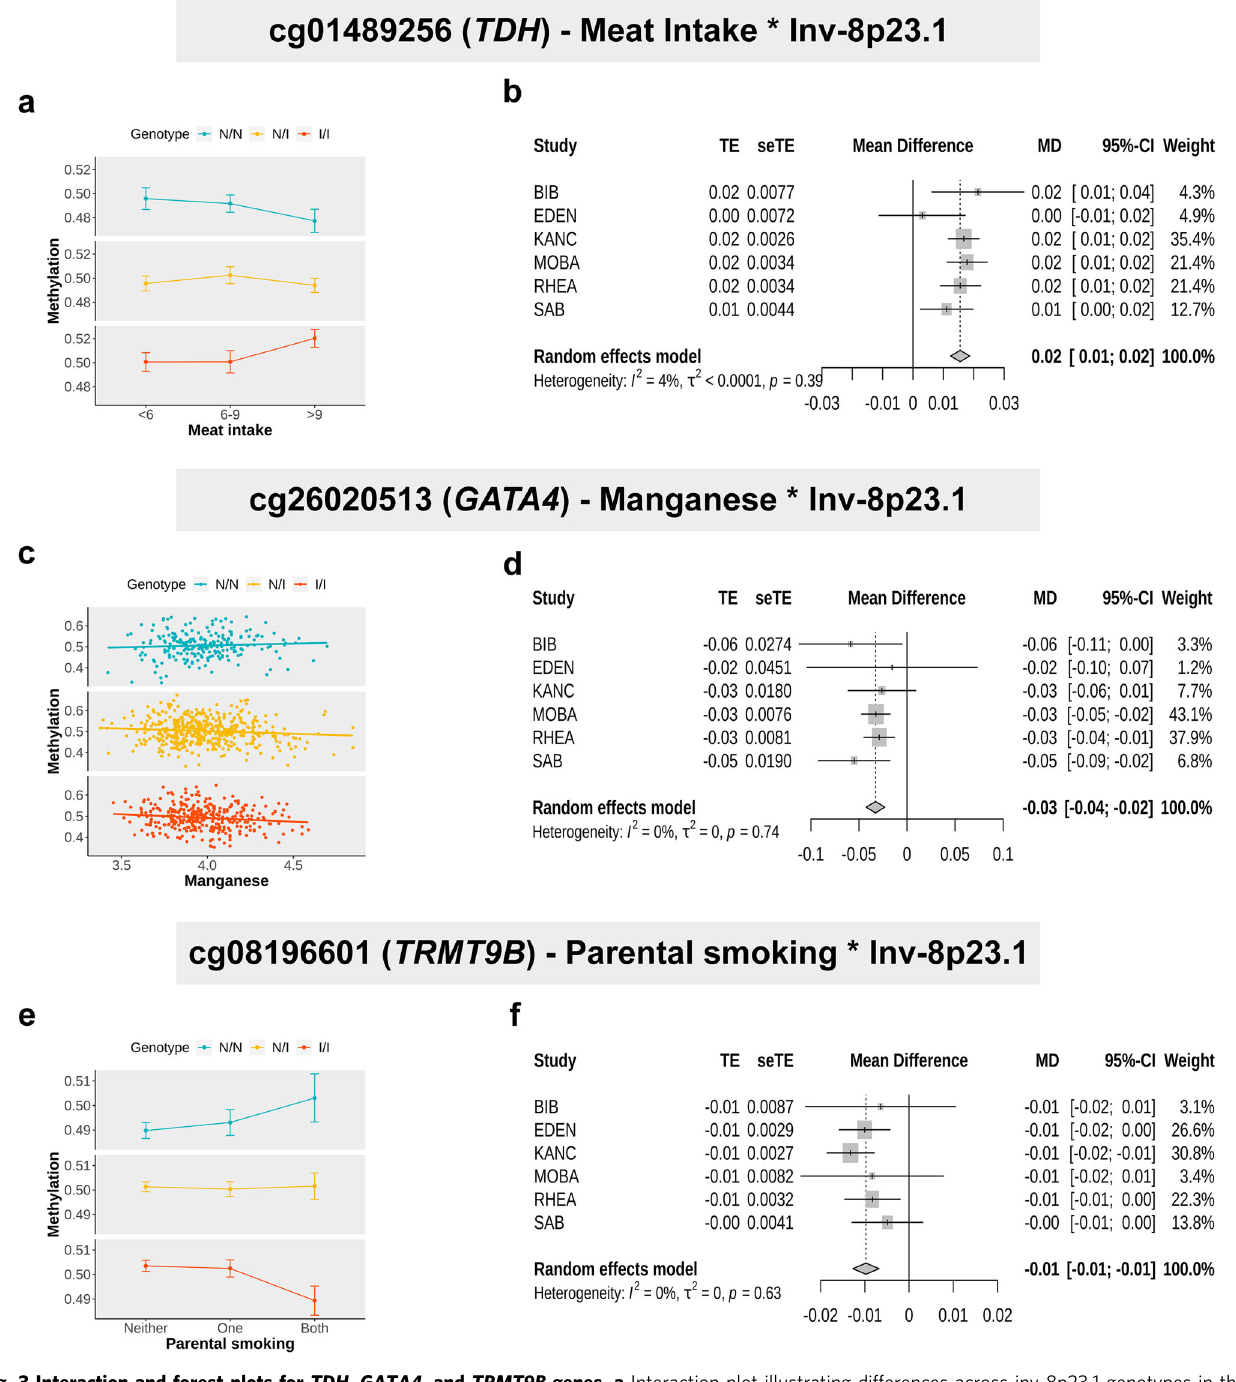
Fig. 3 Interaction and forest plots for TDH, GATA4 , and TRMT9B genes. a Interaction plot illustrating differences across inv-8p23.1 genotypes in the association between cg01489256 ( TDH ) methylation and meat intake (expressed in servings per week). Methylation means the given meat-intake status and inversion genotype are represented with their 95% con fi dence intervals ( N = 1009). b Forest plot showing the meta-analysis effect estimates of inv- 8p23.1 – meat-intake interaction on cg01489256 methylation across HELIX cohorts. c Interaction plot illustrating differences across inv-8p23.1 genotypes in the association between cg26020513 ( GATA4 ) methylation and manganese ( N = 1009). d Forest plot showing the meta-analysis effect estimates of inv- 8p23.1 – manganese interaction on cg26020513 methylation across HELIX cohorts. e Interaction plot illustrating differences across inv-8p23.1 genotypes in the association between cg08196601 ( TRMT9B ) methylation and parental smoking ( N = 1009). f Forest plot showing the meta-analysis effect estimates of the inv-8p23.1 – parental smoking interaction on cg08196601 methylation across HELIX cohorts. Blue points and lines illustrate noninverted homozygous (N/N), yellow illustrates heterozygous (N/I), and orange illustrates inverted homozygous (I/I) individuals. The error bar represents one standard deviation.